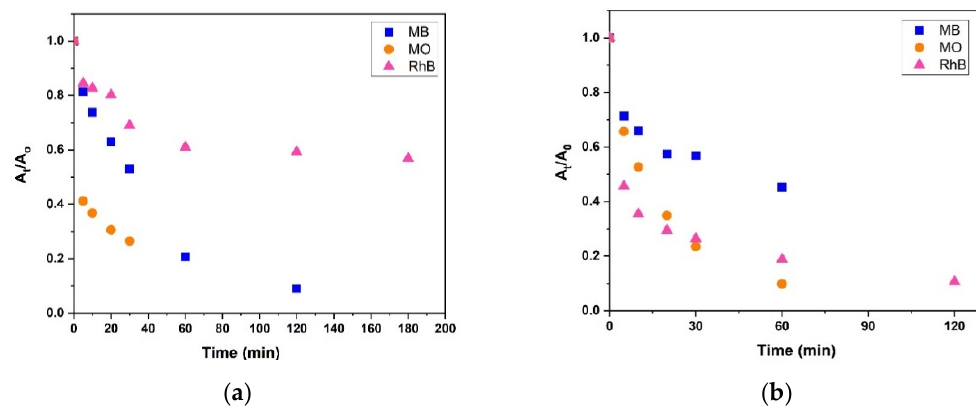
Figure 5 . Plot of A t /A 0 vs. time for decolorization of 3 dyes (MB, MO, and RhB) using( a ) [Mn L 1 Cl] and ( b ) [Fe L 1 Cl] as catalysts. [Note: The time = 0 initial points for all three dyes are congruent, as the time = 0 point is defined as 1.0 in the ratio A t /A 0 for all three dyes. Individual plots of each dye are available in the supplementary information.].